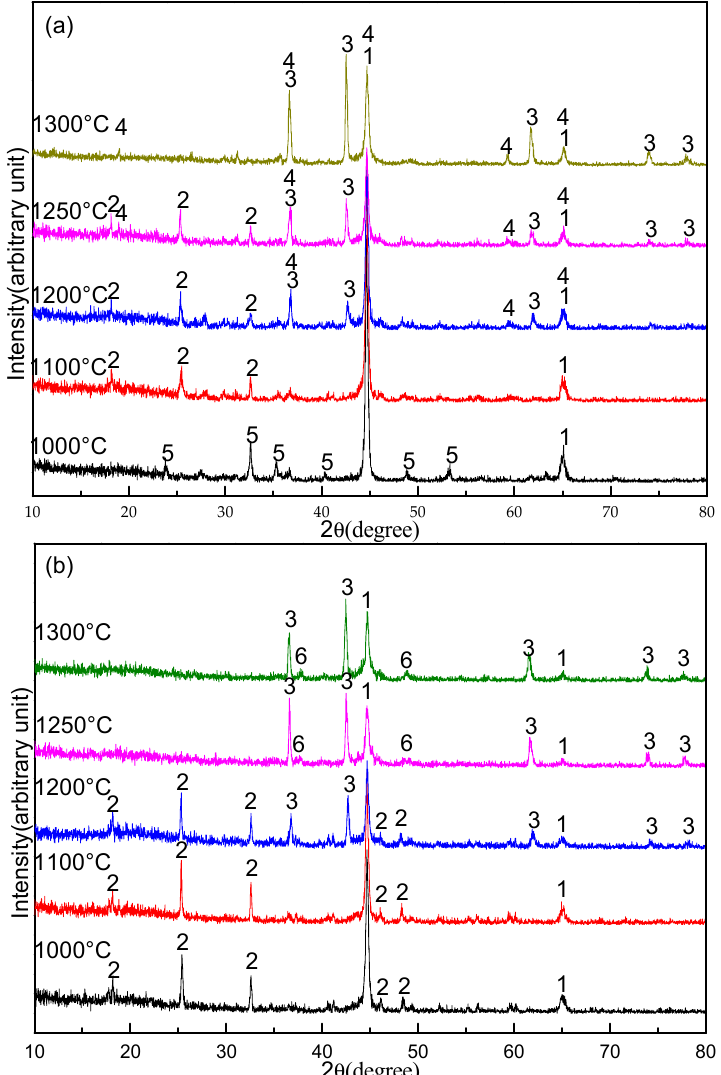
Figure 4. XRD patterns of the pellets reduced at different temperatures for 90 min: ( a ) without additive and ( b ) with 16% sodium borate. 1—Fe(PDF#06-0696); 2—M 3 O 5 (Fe 2 TiO 5 , PDF#41-1432; Mg 2 TiO 5 , PDF#35-0796; Ti 3 O 5 , PDF#09-0309); 3—TiN(PDF#38-1420); 4—MgAl 2 O 4 (PDF#21-1153); 5—FeTiO 3 (PDF#29-0733); 6—Fe 3